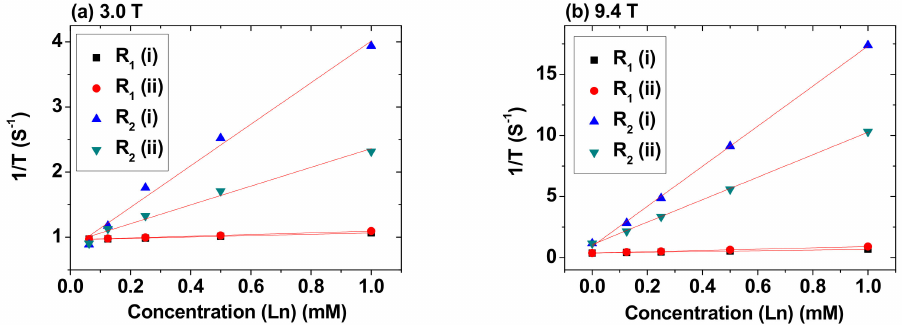
Figure 7. Plots of 1/T 1 and 1/T 2 versus Ln-concentration at ( a ) 3.0 T and ( b ) 9.4 T. Labels (i) and (ii) indicate the PAA-coated Ln 2 O 3 NPs [Ln = (i) Tb and (ii)